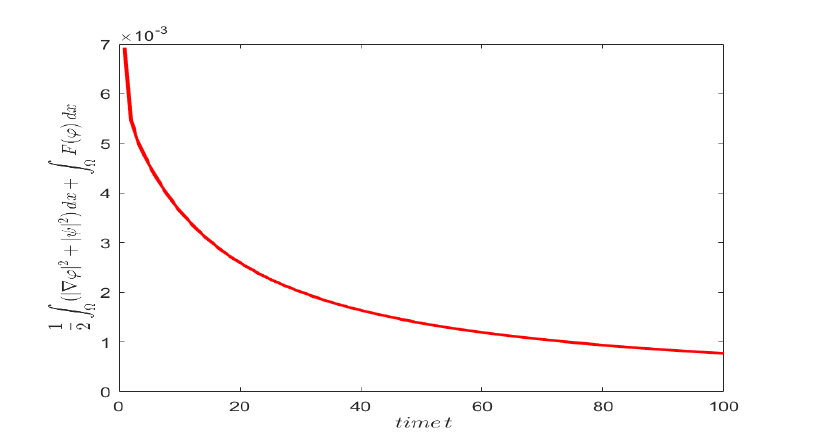
Figure 14. The total energy defined in (3) of the